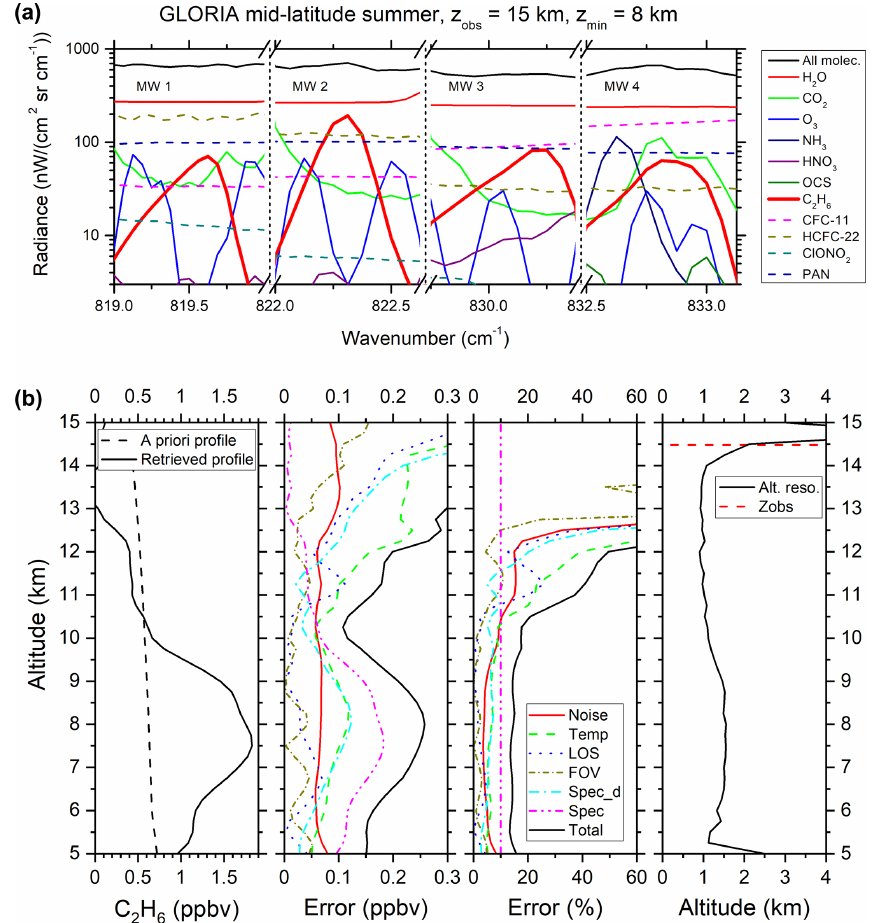
Figure 2. Simulated limb emission spectra (with spectral resolution of GLORIA) for a mid-latitude summer standard atmosphere (Remedios et al., 2007) in four microwindows in the spectral region of the C 2 H 6 ν 9 band centred at 822cm − 1 for a tangent altitude of 8km. Emissions of individual species contributing to the combined spectrum (all molecules, black line) are shown (a) . Retrieved C 2 H 6 VMR vertical profile (and a priori profile) of the limb sequence measured at 13 September 2017 at 16:55UTC combined with absolute and relative errors and the altitude resolution (Alt. reso.), determined from the full width at half maximum of the rows of the averaging kernel matrix, together with the observer altitude ( z obs ). The following individual 1 σ errors are shown: spectral noise (red solid line), temperature (green dashed line), line of sight (LOS; blue dotted line), field of view (FOV; dark yellow short dash dotted line), spectroscopic data of disturbing gases (cyan dash dotted line), spectroscopic data of target molecule C 2 H 6 (dash dotted magenta line), and total error (solid black line) (b) .